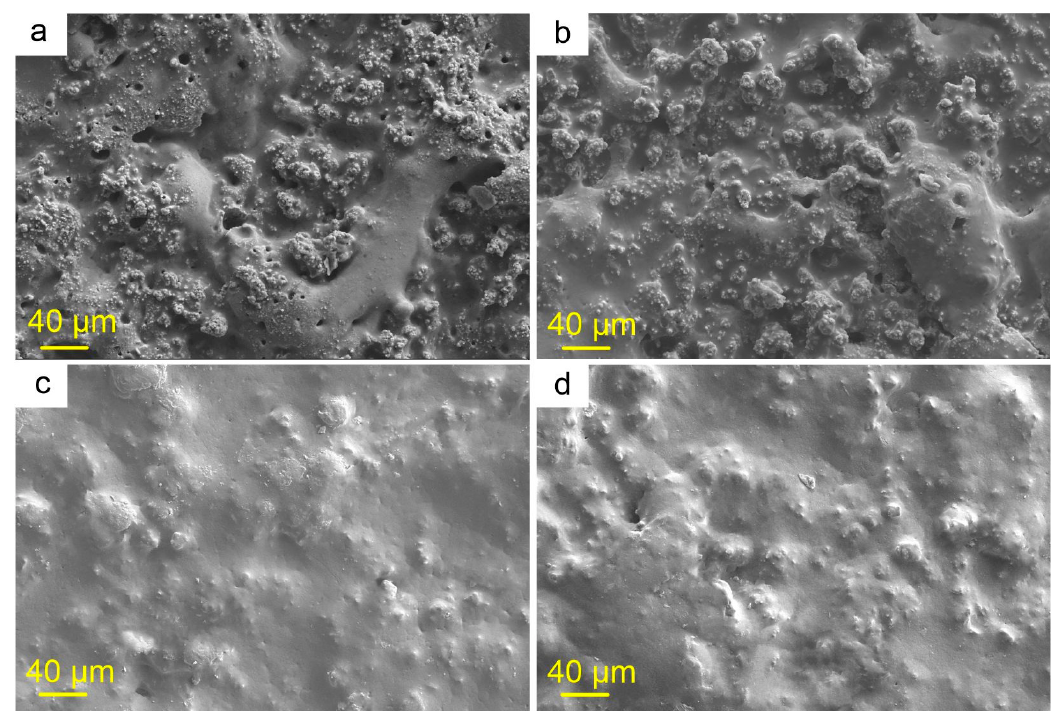
Figure 3. SEM images of PEO-coated samples treated with a 3 wt.% ( a , b ) and 6 wt.% ( c , d ) solution of polycaprolactone in acetone ( a , c ) and dichloromethane ( b , d ).